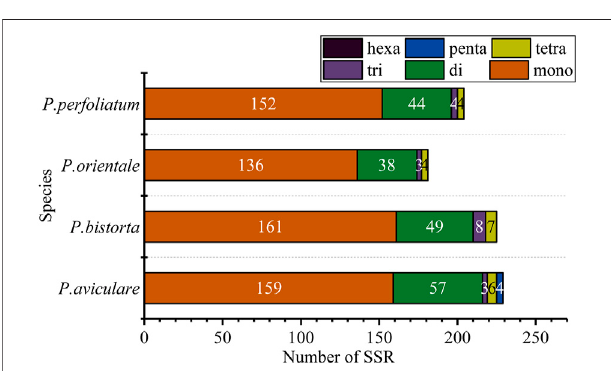
FIGURE 3 | SSR analysis of four cp genomes. The ordinate represents the number of SSRs.